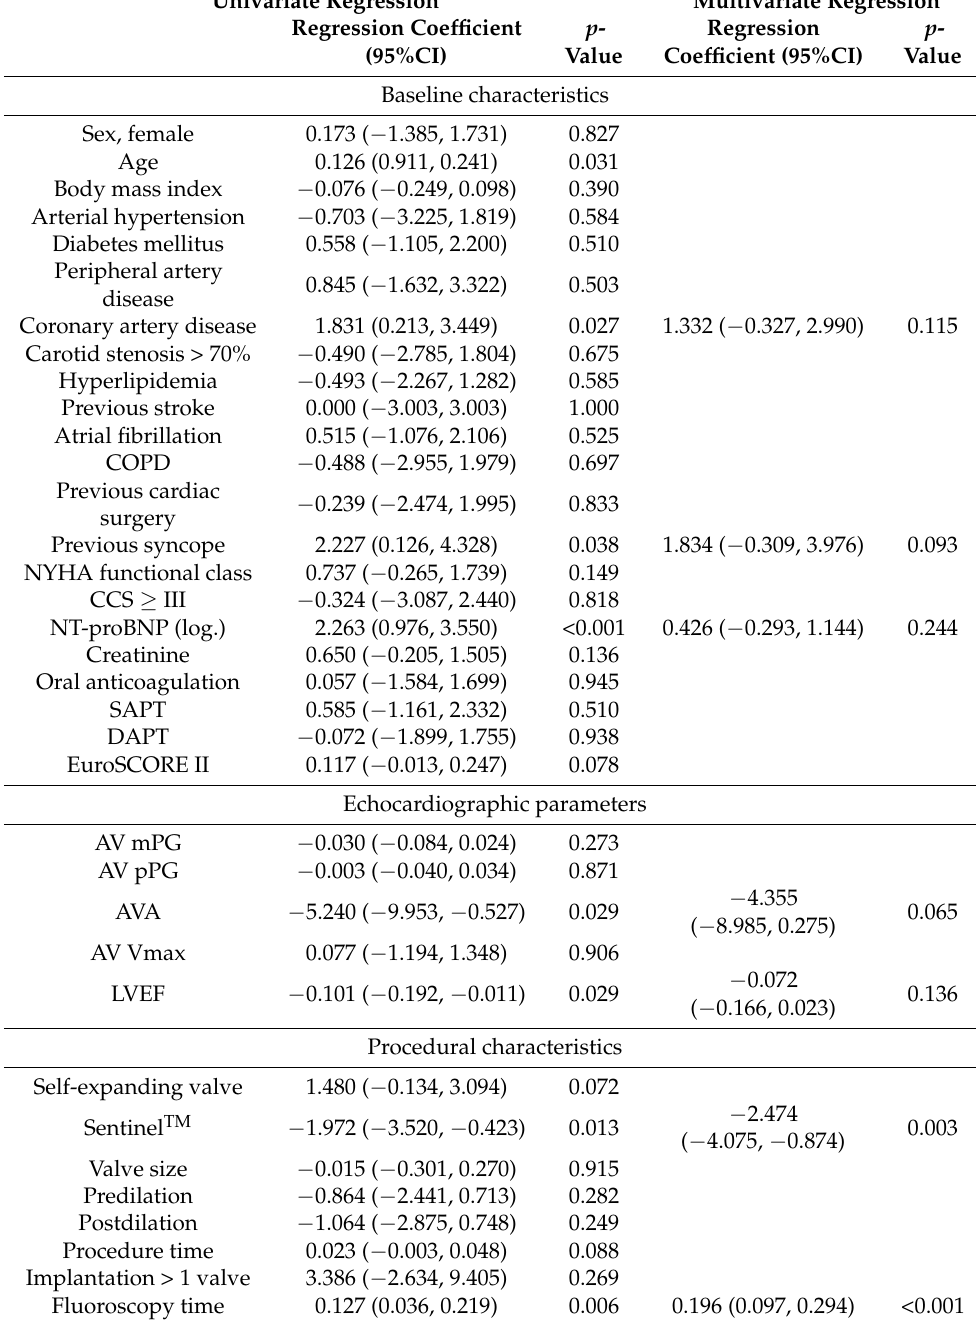
Table 5. Linear regression analysis—Length of hospital